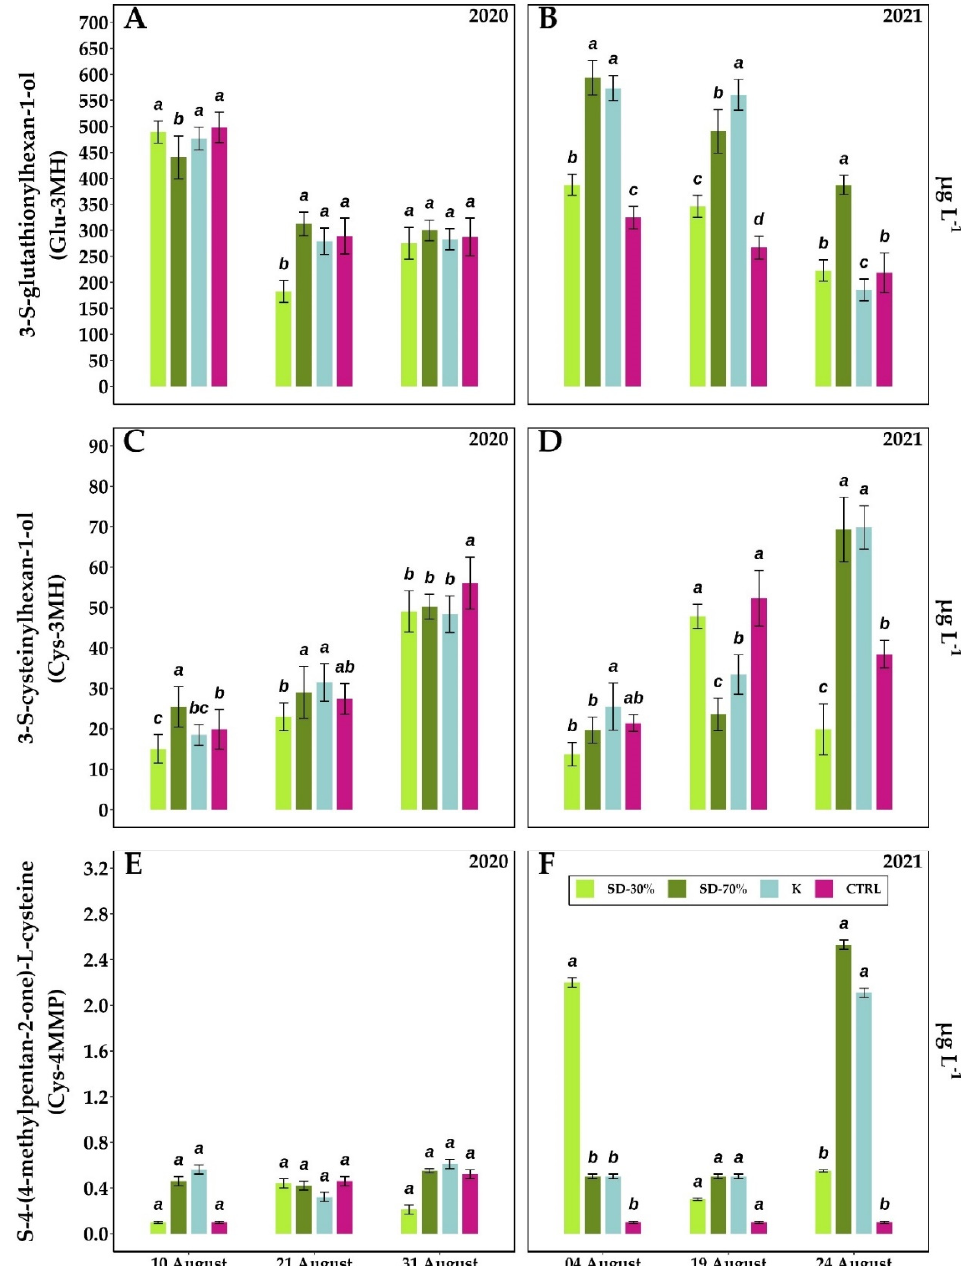
Figure 8. Aromatic maturity. 3-S-glutathionylhexan-1-ol (Glu-3MH; A , B ), 3-S-cysteinylhexan-1-ol (Cys-3MH; C , D ), and S-4-(4-methylpentan-2-one)-L-cysteine (Cys-4MMP; E , F ), contents of Vitis vinifera treated with green artificial shading net at 30% (SD-30%), green artificial shading net at 70% (SD-70%), kaolin (K), and no treatment (CTRL), during two seasons (2020–2021). Measurements were conducted at full veraison (10 August 2020 and 4 August 2021), mid maturation, berries with intermediate sugar values (21 August 2020 and 19 August 2021), and harvest (31 August 2020 and 24 August 2021). Data (mean ± SE, n = 10) were subjected to one-way ANOVA. In each measured parameter (Cys-4MMP, Cys-3MH, and Glu-3MH) the statistical difference is represented by letters; within the single date, a grouping of columns, the statistical differences between the treatments (SD30%, SD70%, K, and CTRL) are represented by different letters (a, b, c) (LSD test, p ≤ 0.05). The same letter pictured on different treatments indicates no significant difference among them.